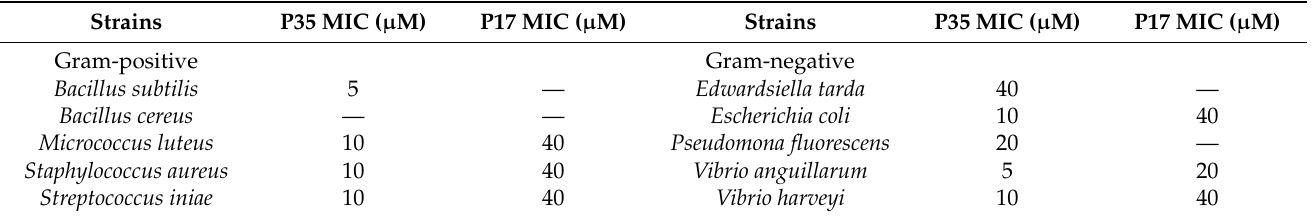
Table 1. The minimal bacterial inhibitory concentration (MIC) of P35 and P17.